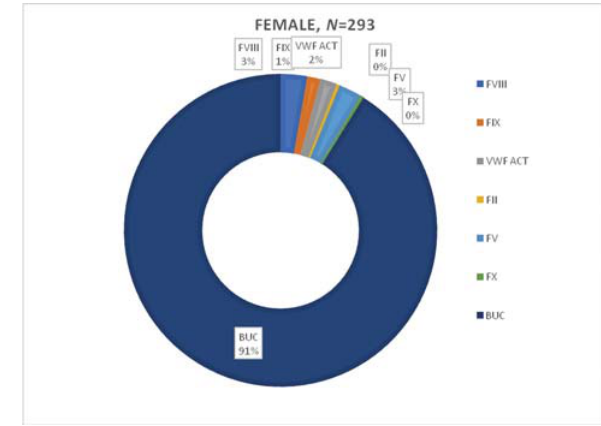
Fig. 1 Factors de fi ciency in males. Fig. 2 Factor de fi ciency in